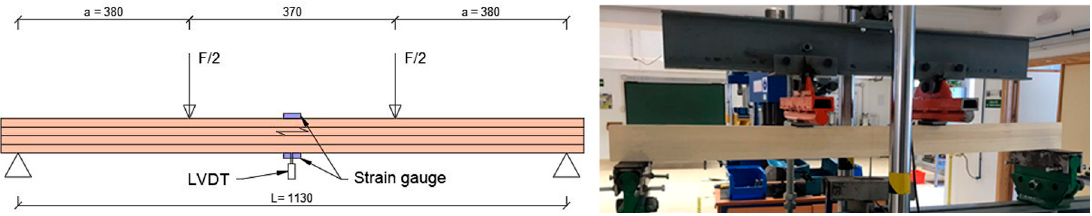
Figure 6. Left: Four-point bending test arrangement. Right: single-species poplar sample during the bending test. Distances in mm.